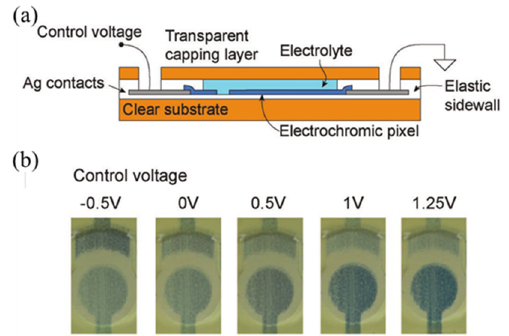
Figure 13. ( a ) Schematic cross-section of the electrochromic pixel. ( b ) The transmitted color through the sealed printed pixel placed above a white paper in natural light. The circular pixel is reduced as the control voltage is increased [95].